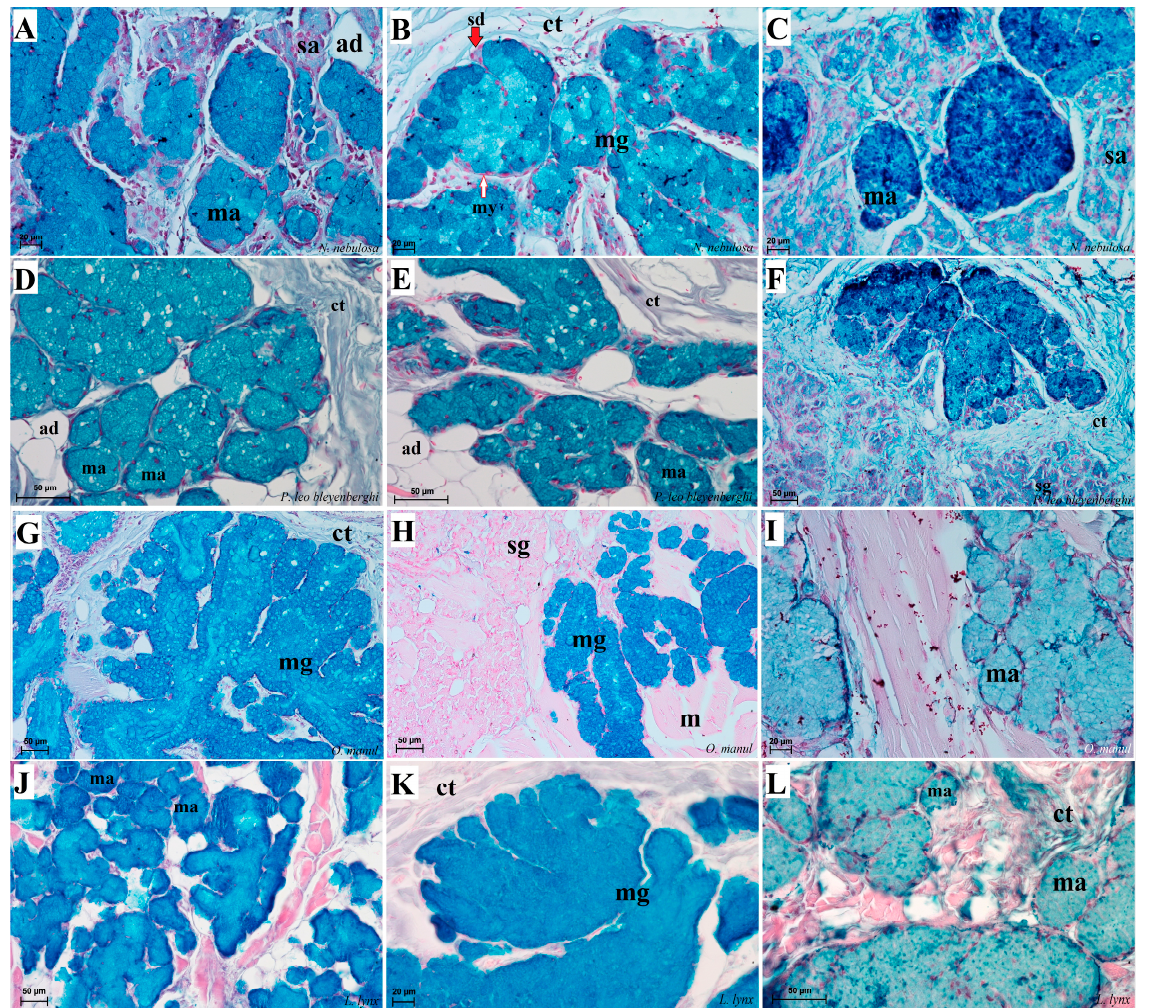
Figure 14. Histochemical analysis (AB pH 1.0, AB, pH 2.5 and HDI staining) of the mucous synthesis in the posterior lingual glands of the four species of undomesticated Felidae: N. nebulosa ( A – C ), P. leo bleyenberghi ( D – F ), O. manul ( G – I ) and L. lynx ( J – L ). ( A , D , G , J ) Mucoserous glands (with dominance of mucous acini). Strong positive reaction (+++) in mucous acini. ( B , E , H , K ) Strong positive reaction (+++)—blue color in mucous acini, while negative reaction in serous cells of serous demilunes ( B ). ( C , F , I , L ) Strong positive reaction (+++) in mucous acini ( C , F ), positive reaction (+) in mucous acini ( I , L ) and negative reaction ( − ) in serous acini ( C , F ). AB pH2.5 staining ( A , D , G , J ); AB pH1.0 staining ( B , E , H , K ); HDI staining ( C , F , I , L ). Bar = 50 µm (D–H,J,L); bar = 20 µm (A–C,I,K). Abbreviations: ct—connective tissue, m—muscle fibers, ma—mucous acini (round secretory units), mg—mucoserous glands with the dominance of mucous acini, my—myoepithelial cell (white arrow), sa—serous acini, sd—serous demilunes (red arrow), sg—serous glands.